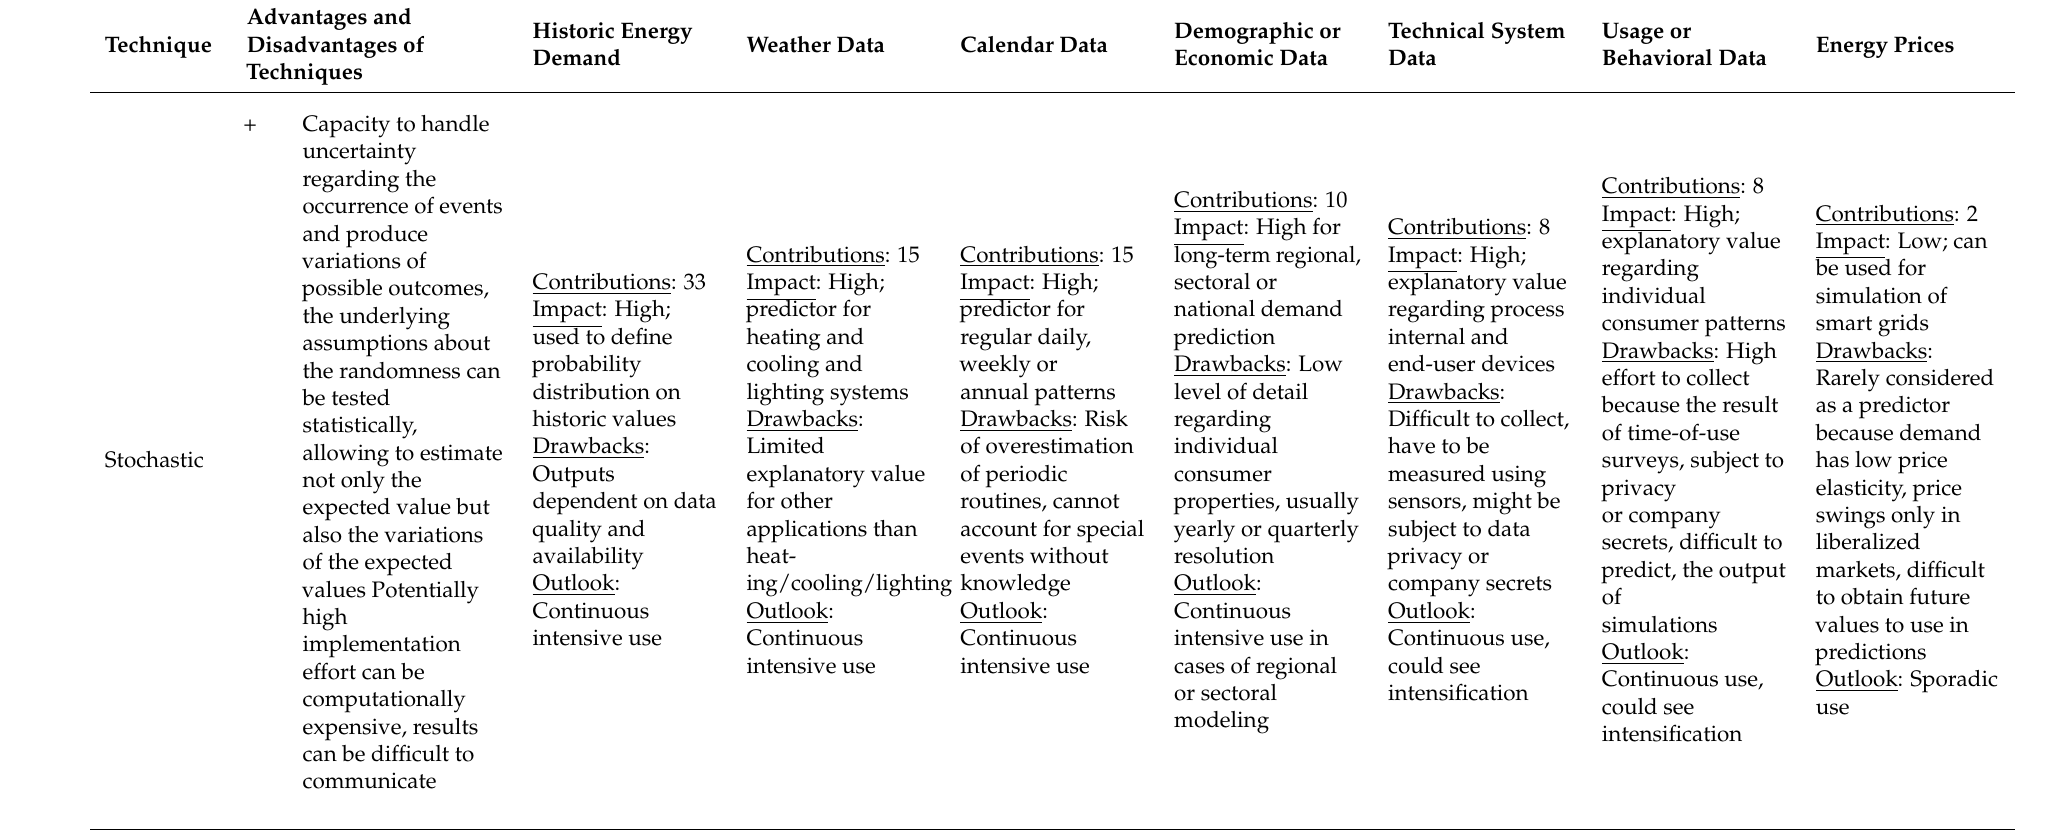
Table 7. Techniques and input data used (4/5). Continuation of Table